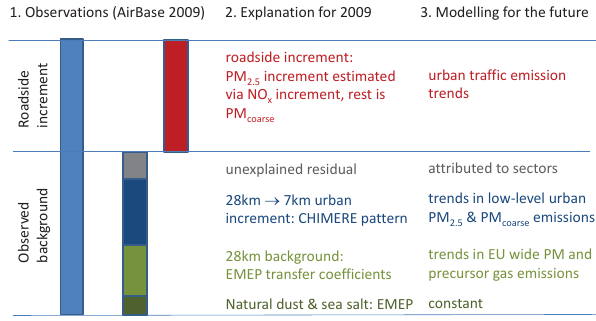
Figure 2. Schematic overview of the PM 10 modelling scheme for roadside